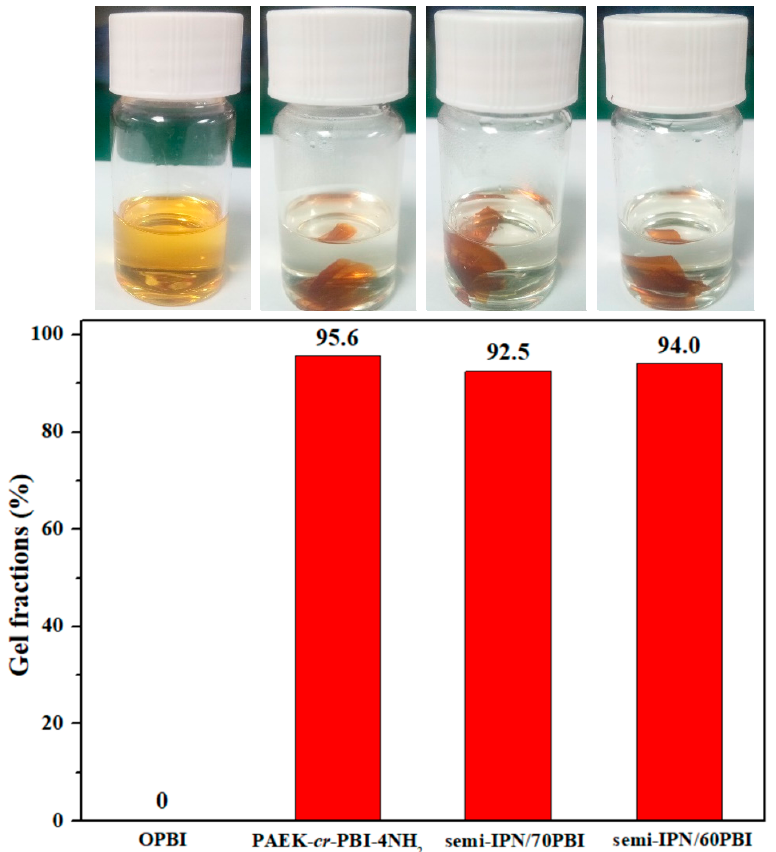
Figure 3. Gel fractions of OPBI, PAEK- cr -PBI, and semi-IPN/ x PBI membranes after immersing in NMP at 100 °C for 48 h.